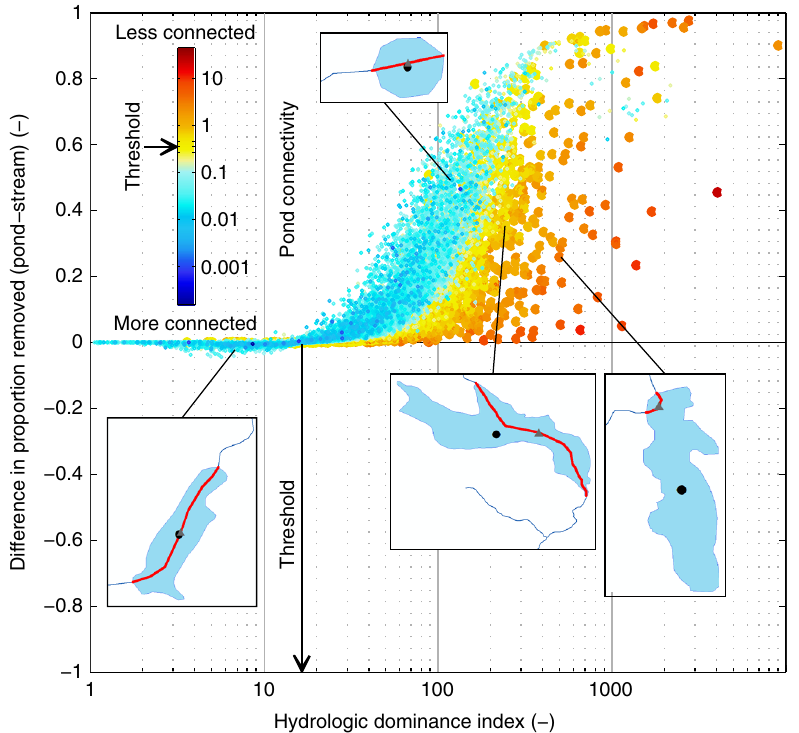
Fig. 3 Proportion of total nitrogen removed annually by an individual ponded water relative to its stream replacement (expressed as a difference) across varying degrees of pond connectivity. The results shown here are of the New England sub-region and for ponded waters with only one intersecting stream reach (see Supplementary Fig. 3 for the remaining ponded waters and for the Chesapeake Bay sub-region). The dominance of a ponded water to remove nitrogen starts to decrease at a threshold in ponded connectivity of 0.36 (±0.09) (see Methods); the dot-plot is colored by pond connectivity (see Eq. (4)) where larger dots designate values above the threshold. Small values of pond connectivity indicate that the ponded water is more connected to the network while large values indicate the ponded water is less connected to the network, as illustrated by the shape examples. The black dots on the shape examples designate the centroid of the ponded water and the gray triangles designate the midpoint of the intersecting stream reach (in red). The threshold in the hydrologic dominance index where a ponded water becomes dominant occurs when it is equal to the ratio of stream to ponded water biological activities, which results from the case when the associated Damköhler numbers are equal (see Eq.